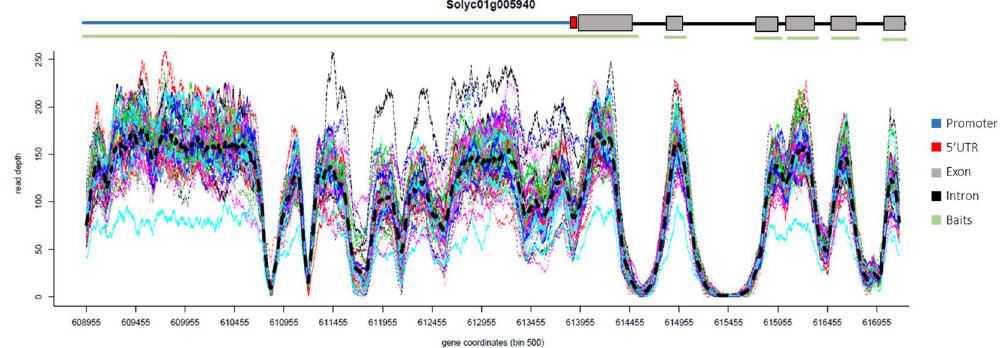
Figure 3. Per-base depth of coverage across gene Solyc01g005940 for the 47 tomato genotypes. Mean value for coverage depth is represented in black bold dashed line. Gene structure and bait positions are shown above the multi-line graph.